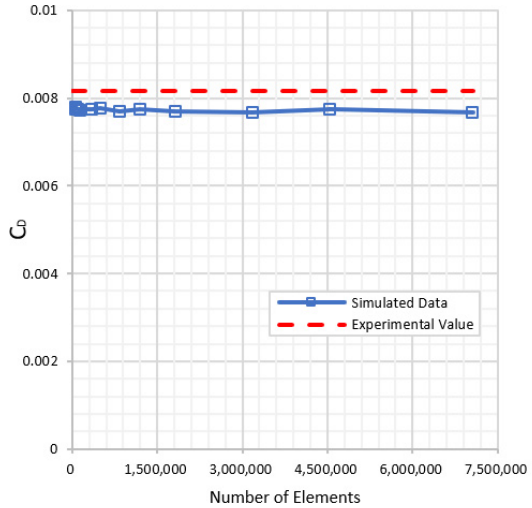
Figure 4. Mesh Independence Study (NACA Airfoil, Re = 6 Million, α = 0°).